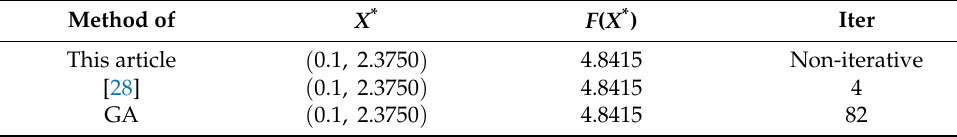
Table 6. Optimal solution and optimal value for (23) obtained by different methods. Method of X * F ( X * ) Iter This article ( 0.1, 2.3750